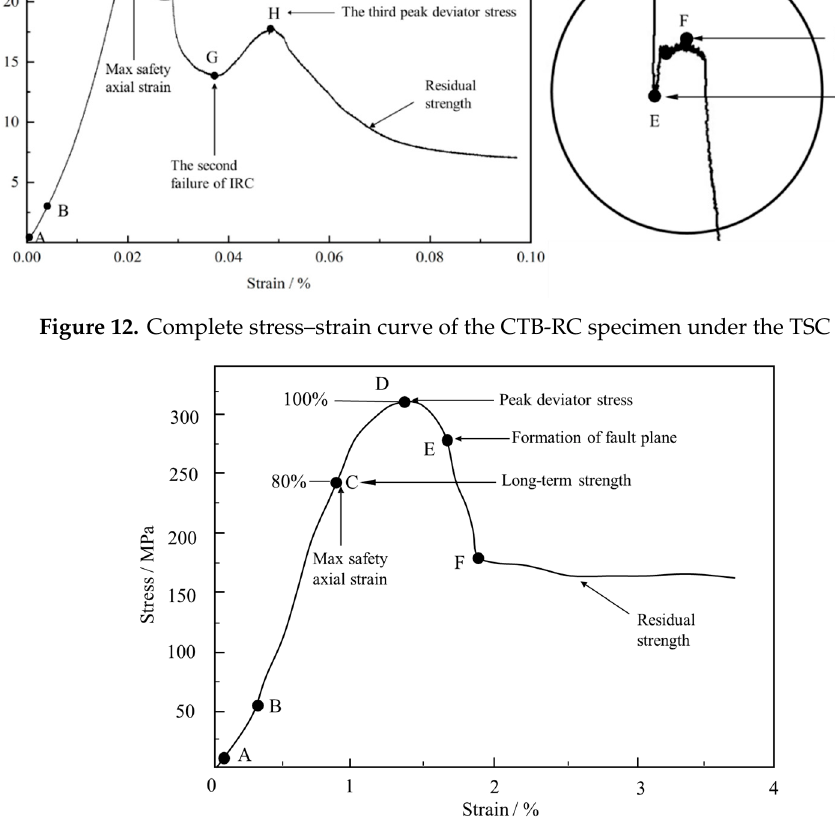
Figure 13. Complete stress–strain curve of the rock samples under the TCS test. There is big difference in the peak deviator stress between the CTB-RC sample and the rock sample, which is caused by the origin source and type of the rock mass.